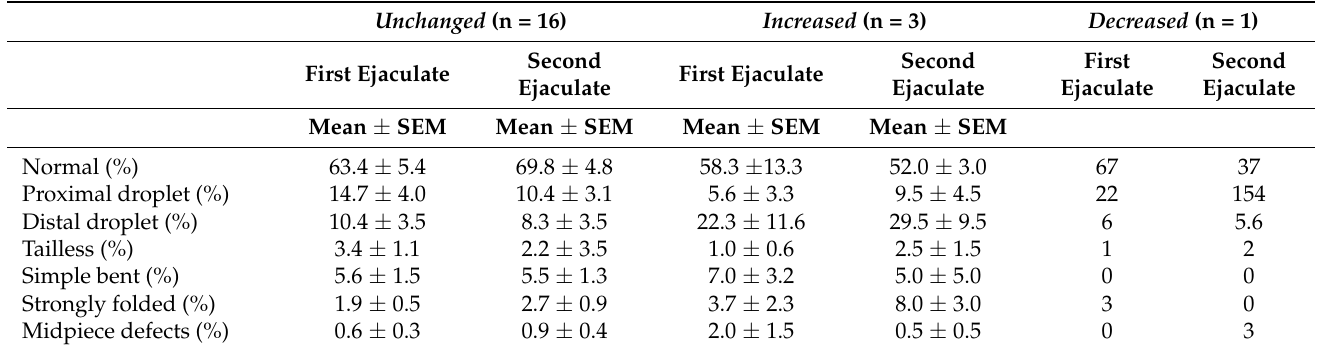
Table 5. Sperm morphology of the first and second ejaculates of the season collected from 20 breeding inactive stallions. Based on the motility parameters between the first and second ejaculates, sixteen stallions were classified as unchanged (i.e., ≤ 10% change), three stallions as increased (i.e., improvement > 10%), and one stallion as decreased (i.e., reduction > 10%).